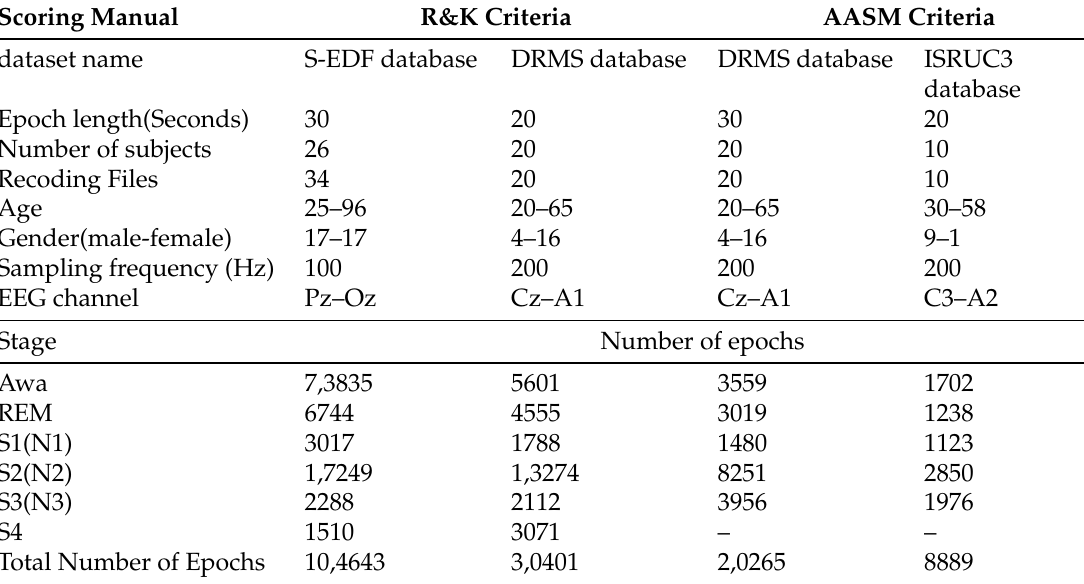
Table 3. The specification of the electroencephalograph (EEG) databases included in this study.